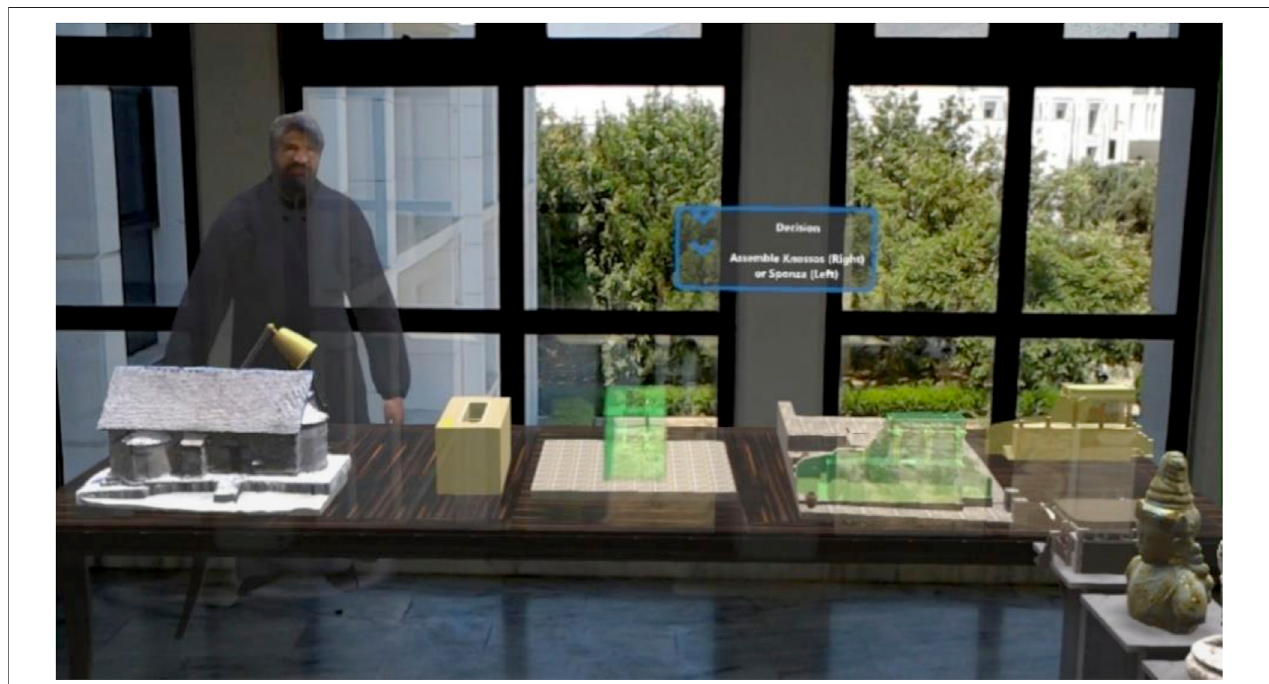
FIGURE 1 | Illustrating an AR virtual museum. On the left, the 3D reconstructed and animated priest of Asinou church in Cyprus (Geronikolakis et al., 2020).